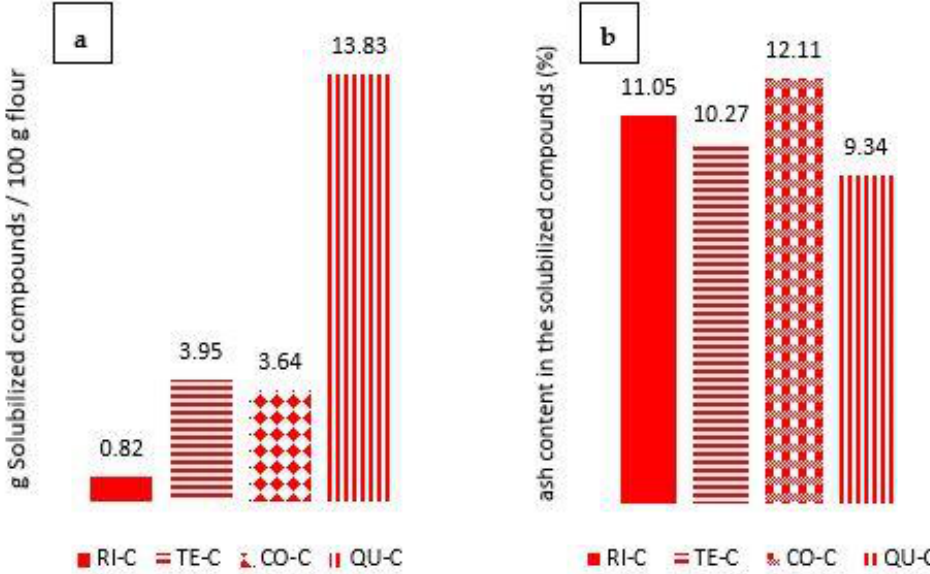
Figure 1. ( a ) Solubilized compounds determined in the supernatant of centrifuged samples, and ( b ) percentual ash content in said soluble fractions.